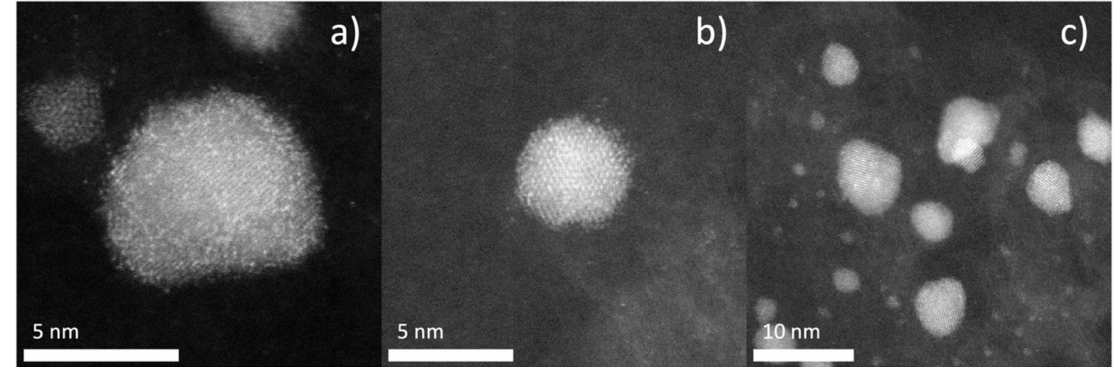
Figure 5. TEM images of Cu 3.3 Pt 1 sample. Z -contrast imaging shows Pt as bright white spots, with Cu shown in darkest gray. The speckling of white spots in ( a , b ) show a uniform distribution of Pt in the shell, lattice fringes arise from ordered Pd core (d-spacing calculated from lattice fringes in images ( b , c ) equal 0.23 nm, corresponding to known d-spacing of Pd (111) diffraction, 0.223 nm) Uniform core-shell formation can be seen in image ( c ) showing even speckling across several